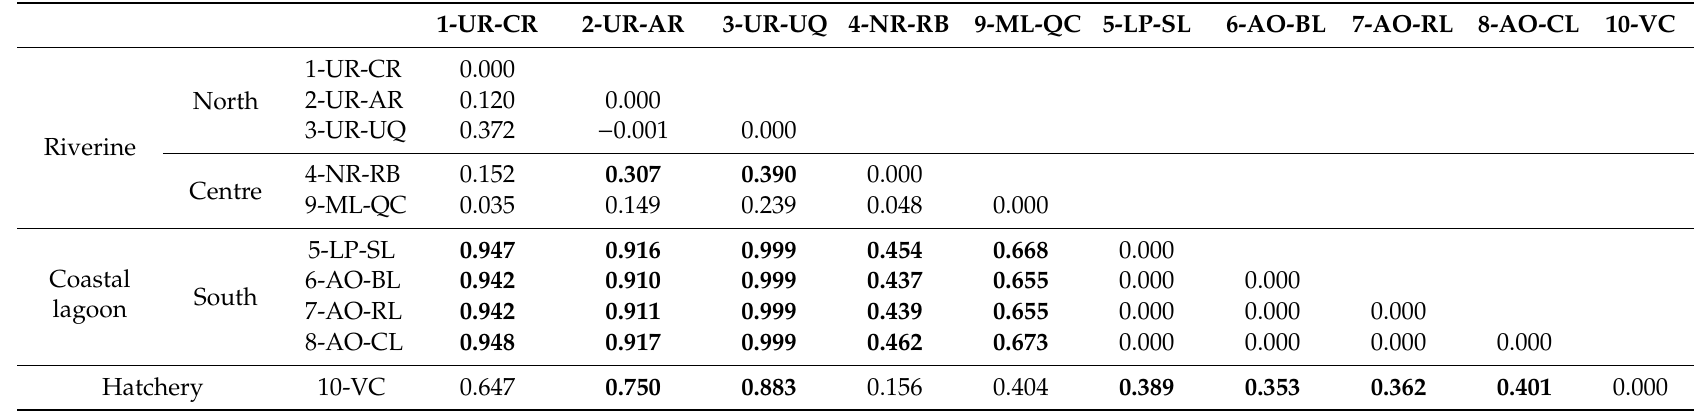
Table 6. Pairwise F ST values between localities based on the dataset of 73 SNP Outlier loci. Significant FST values are highlighted in bold type ( p <